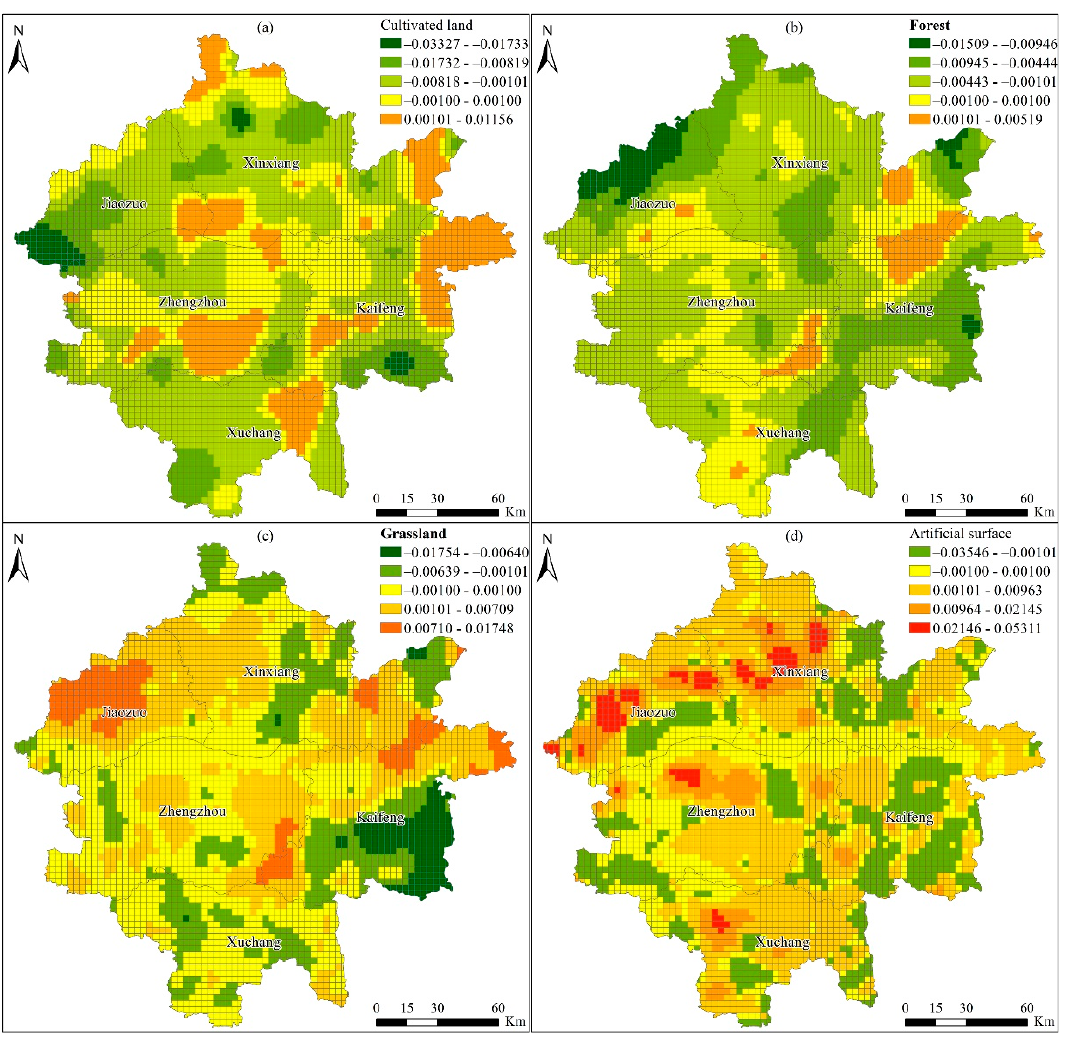
Figure 4. Spatial pattern of the MWGR coefficients for cultivated land ( a ), forest ( b ), grassland ( c ), and artificial surface ( d ).